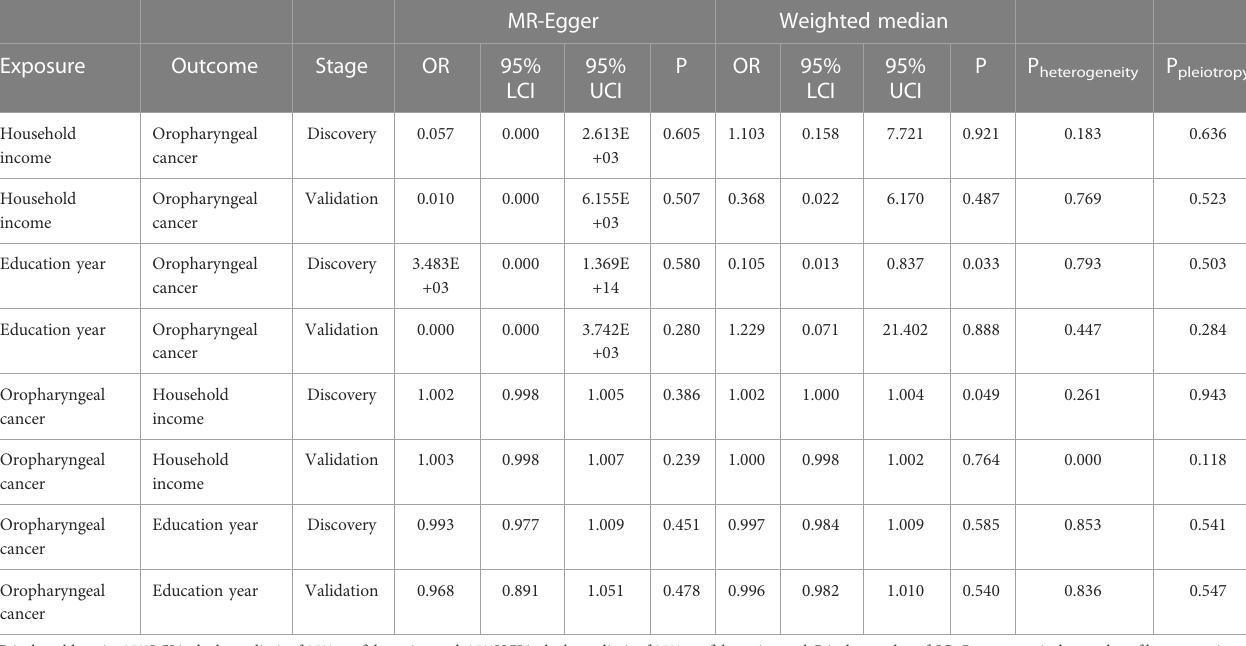
TABLE 2 The Mendelian randomization results of complementary methods.